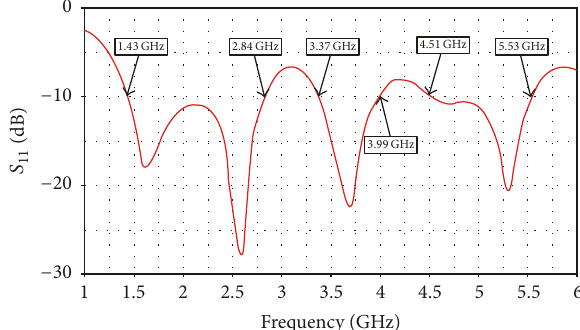
Figure 5: Final simulated return loss for the proposed antenna.